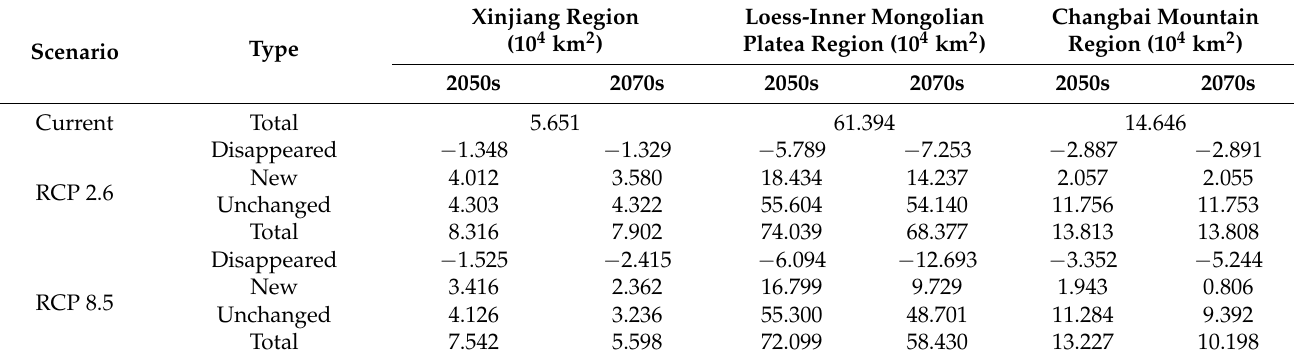
Table 3. Area variation of the suitable habitat in the three kind regions under the future climate scenarios relative to current.